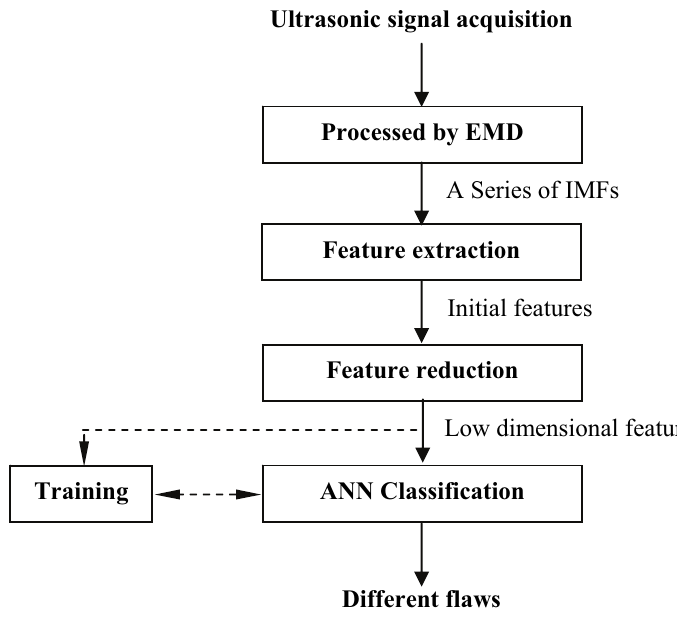
Fig.1. Overall procedure for ultrasonic flaw signal classification